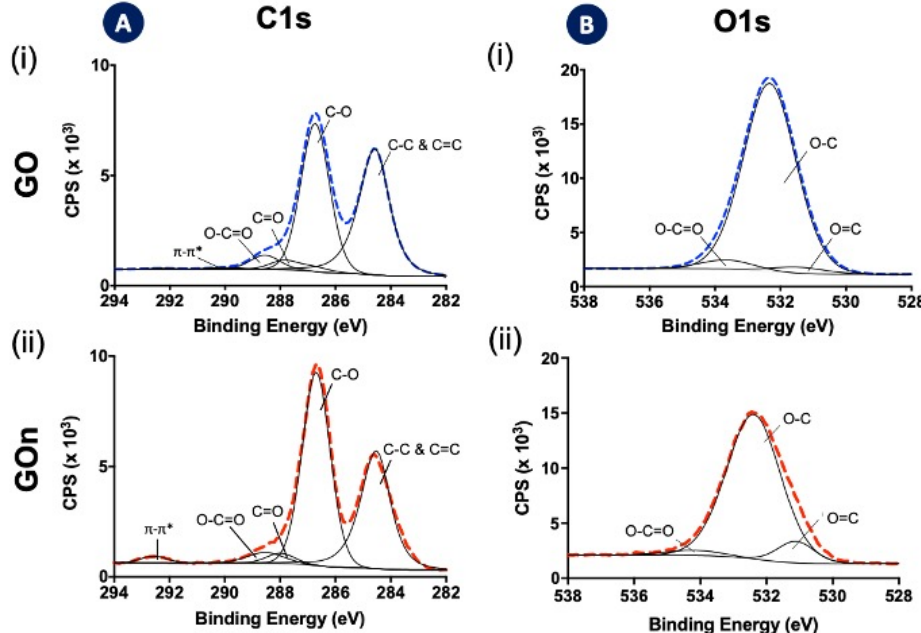
Figure 8. XPS analysis of (i) GO and (ii) GOn. Deconvolution of high-resolution ( A ) C1s and ( B ) O1s spectra enabled the quantification of functional groups on graphene backbone.